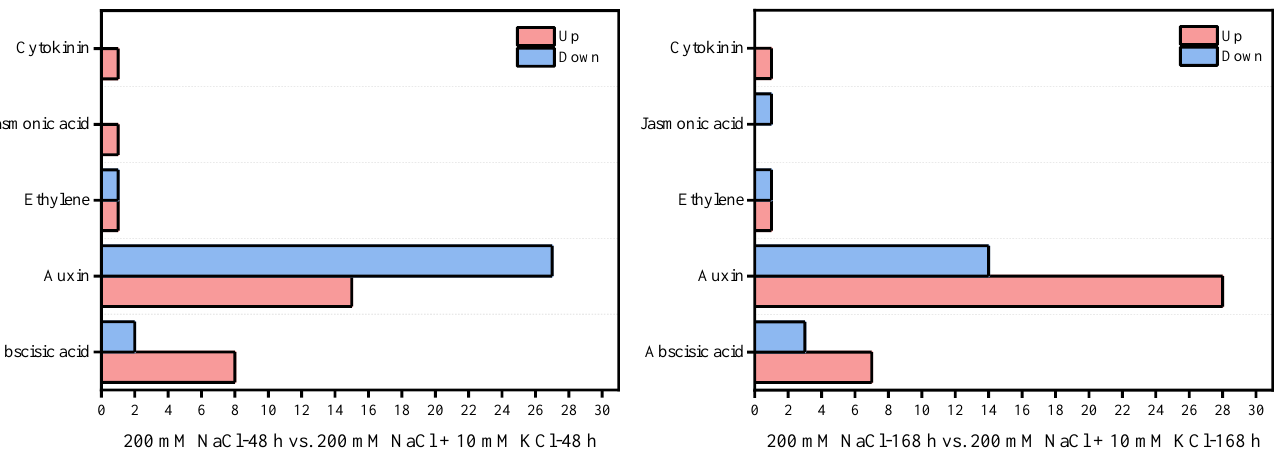
Figure 4. Statistical chart of the expression number of key plant hormone genes in the roots of T. ramosissima by exogenous potassium application under NaCl stress. (The number of up-regulated and down-regulated changes of 56 plant hormone key genes found in the roots of T. ramosissima under NaCl stress for 48 h and 168 h with exogenous potassium).